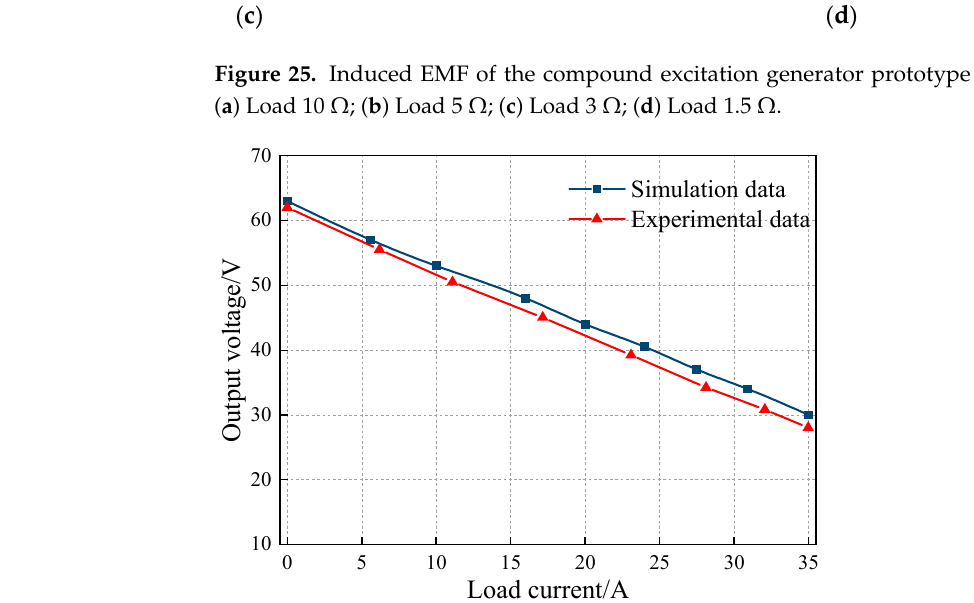
Figure 26. Compound excitation generator external characteristic curve.